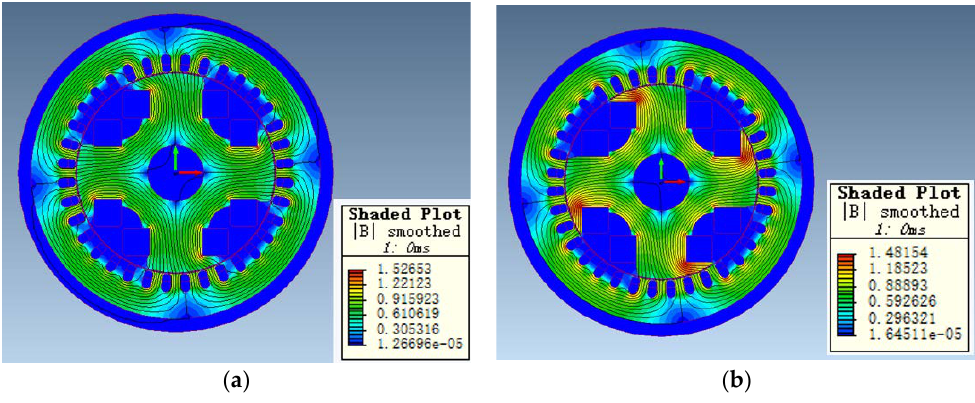
Figure 7. Flux distribution of two optimized rotors. ( a ) Design 1; ( b ) Design 2.